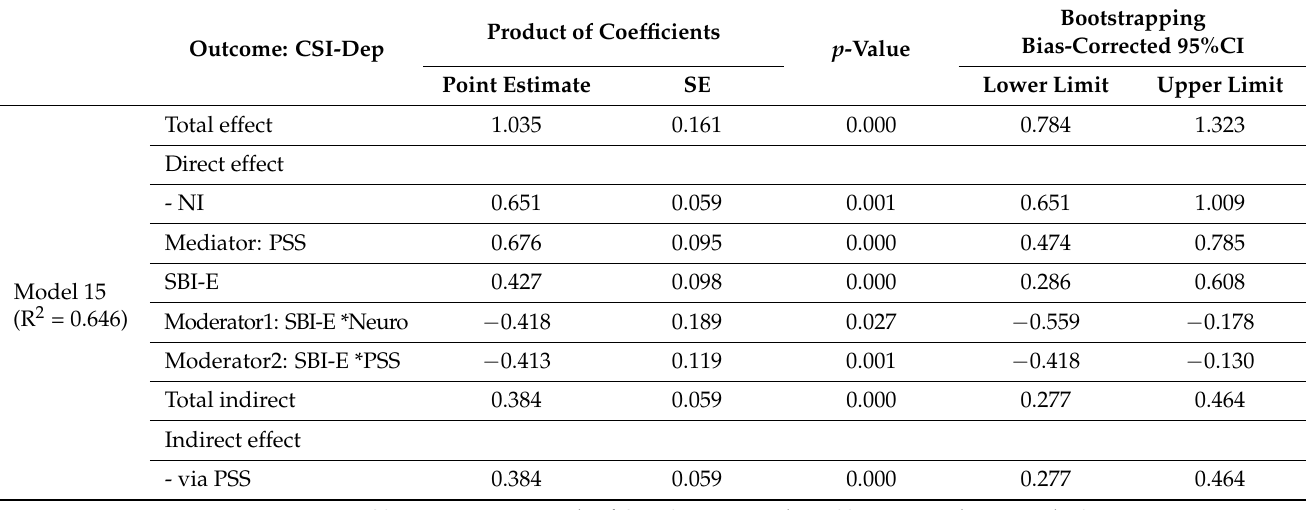
Table 4. Moderated Mediation Effect of Level of Perceived Stress and Equanimity on the Relationship between Level of Neuroticism and Depressive symptoms controlling for age, sex and